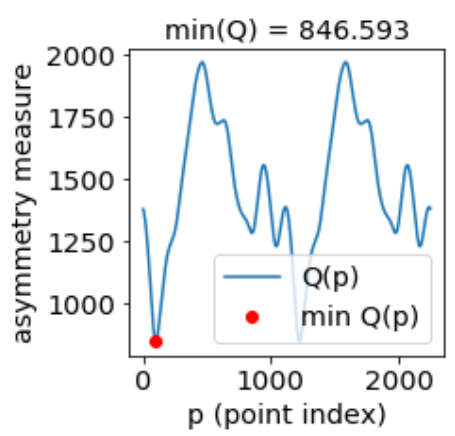
Figure 7. The assymetry measure of the camel contour (Fig. 6) from different contour